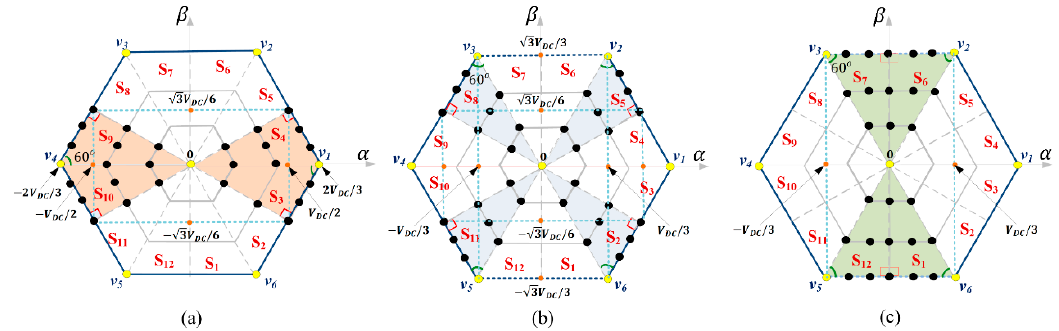
Figure 2. Symmetrical zones of the space vector diagram (SVD) depending on the coefficient values in Table 1 for ( a ) (14), ( b ) (15), and ( c ) (16).